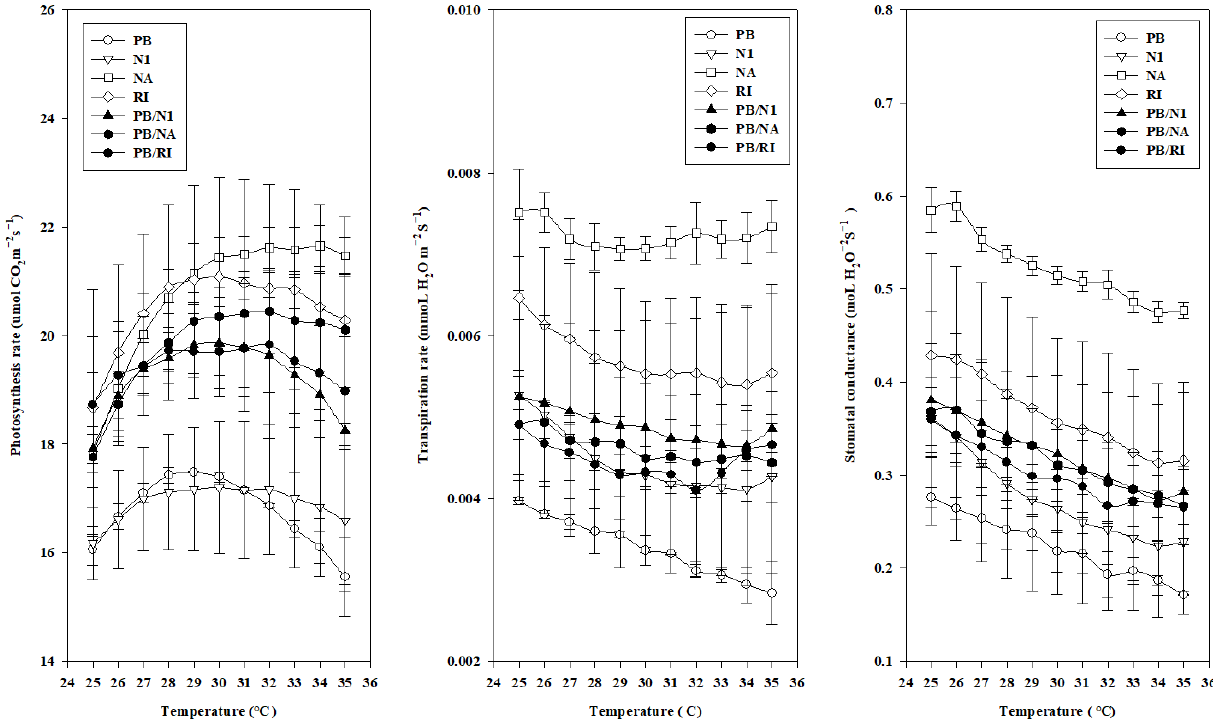
Figure 7. Photosynthetic parameters of one scion, three rootstocks, and three grafted plants under different temperature conditions. (PB): scion cut rose of Rosa hybrida cv. Pink Beauty; (N1): rootstock of Rosa multiflora cv. Hort No 1; (NA): rootstock of Rosa canina cv. Natal brier; (RI): rootstock of Rosa indica cv. Major; (PB/N1): PB grafted onto N1; (PB/NA): PB grafted onto NA; (PB/RI): PB grafted onto RI. Vertical bars are standard deviations ( n = 3).